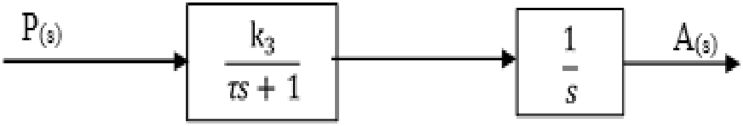
Transfer function block for spray area.